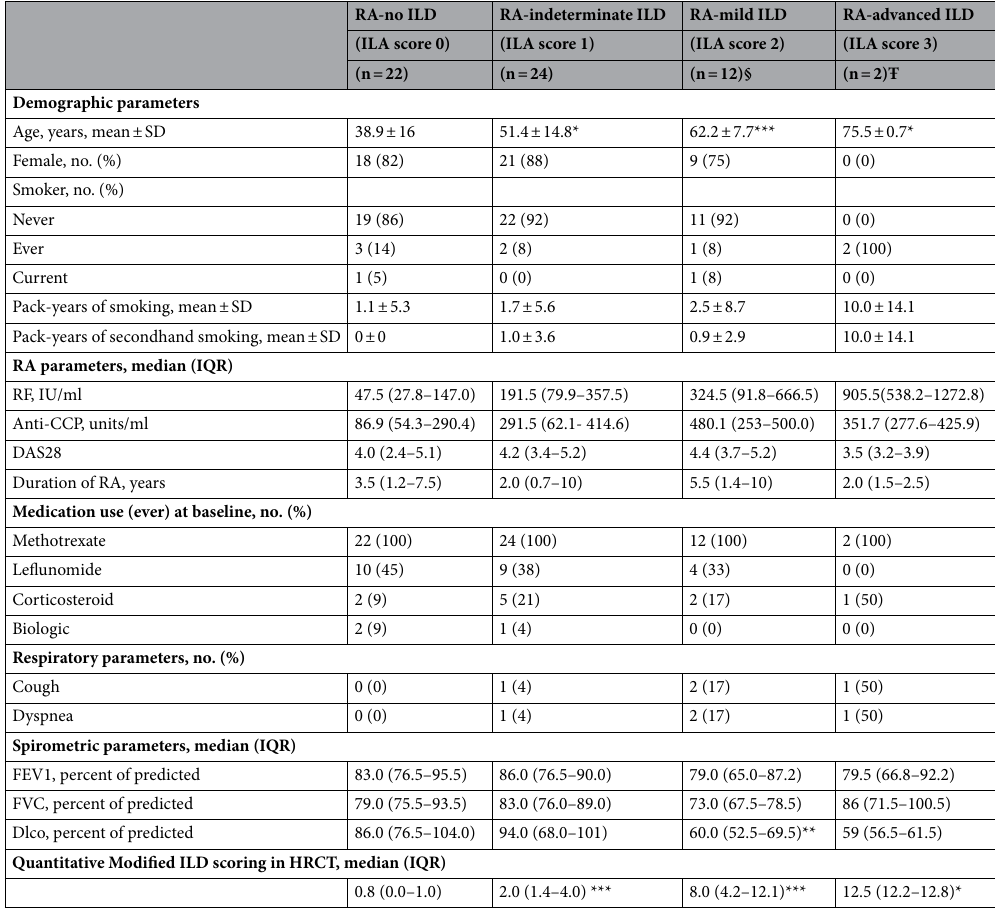
Table 1. Characteristics of 60 RA patients at baseline. RF = rheumatoid factor; anti-CCP = anti–cyclic citrullinated peptide; DAS28 = 28-joint Disease Activity Score. IQR = interquartile range. Age was significantly different among the subgroups: RA-mild ILD (ILA score2) and RA-no ILD (ILA score 0) (p < 0.001), RA– advanced ILD (ILA score3) and RA-no-ILD (ILA score0) ( p < 0.05). The Quantitative Modified ILD scores in HRCT in RA-indeterminate ILD, RA-mild ILD and RA-advanced ILD groups were significantly different than RA-no ILD ( p < 0.001, 0.001 and 0.05, respectively). § n = 1 patient with UIP. Ŧ n = 2 patients with UIP. * p < 0.05, ** p < 0.01, *** p < 0.001 when compared with RA-no ILD at baseline; two sample t-test, Mann–Whitney U test (continuous variables) or Chi-square/Fisher’s exact test (categorical variables) were used to calculate